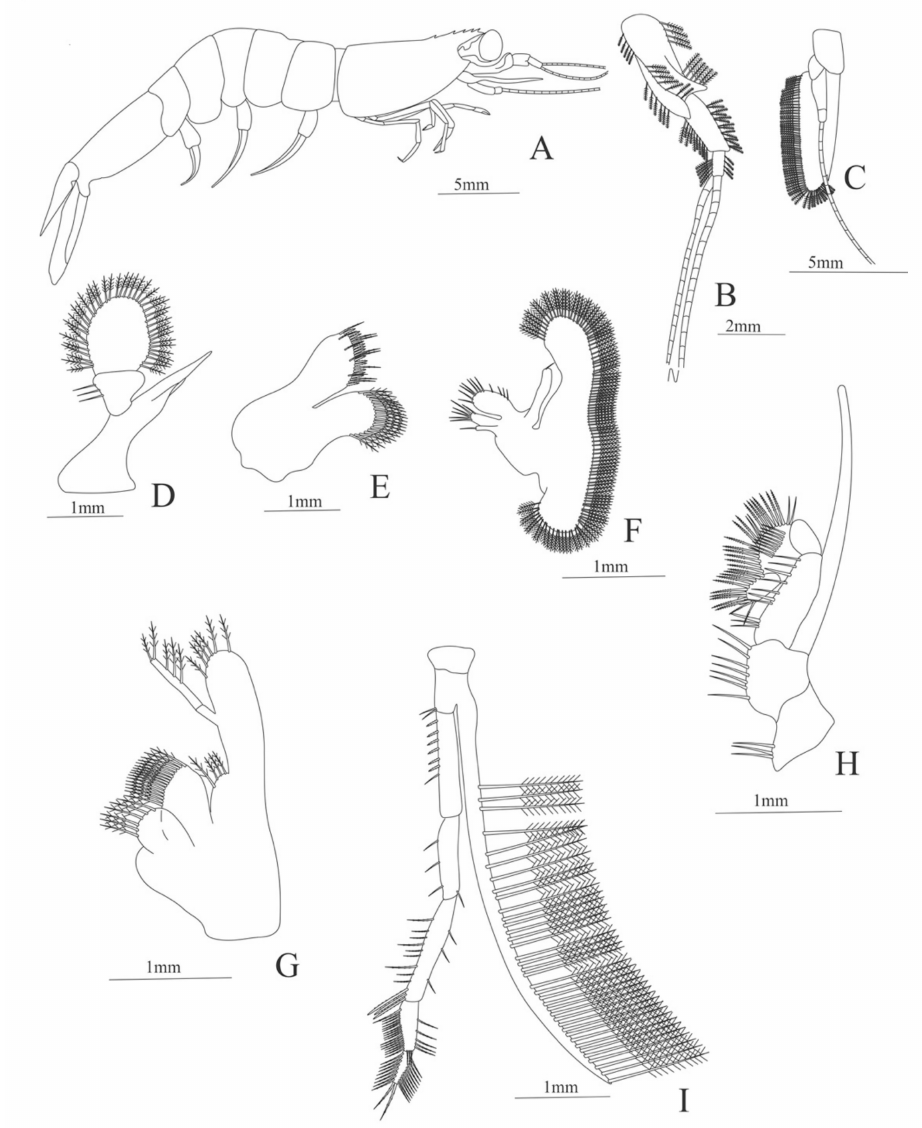
Figure 31. Funchalia villosa : ( A ) lateral view; ( B ) antennule; ( C ) antenna; ( D ) mandible; ( E ) maxillule; ( F ) maxilla; ( G ) first maxilliped; ( H ) second maxilliped; ( I ) third